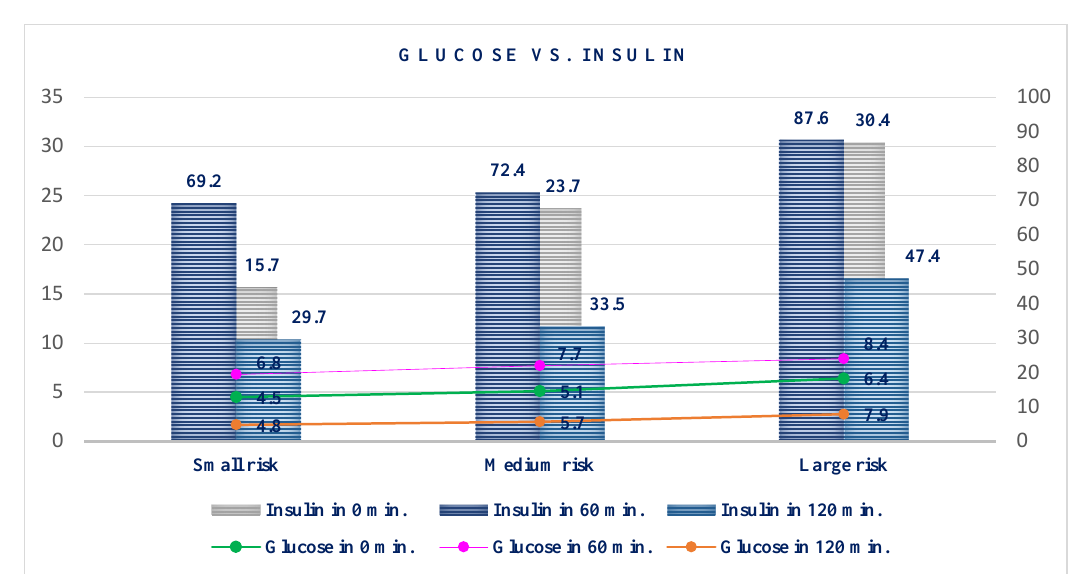
Figure 1. Glucose and insulin at 0, 60, and 120 min. HOMA-IR (Homeostasis Model Assessment of Insulin Resistance) index is calculated based on the value of blood glucose and insulin concentration, according to the formula: (5.6%) subjects, 17 (2.5%) men and 21 (3.1%) women, and they were at medium risk of pre-hyperinsulinemia. HOMA-IR values > 2 were found in 13 (1.9%) subjects, 5 (0.7%)